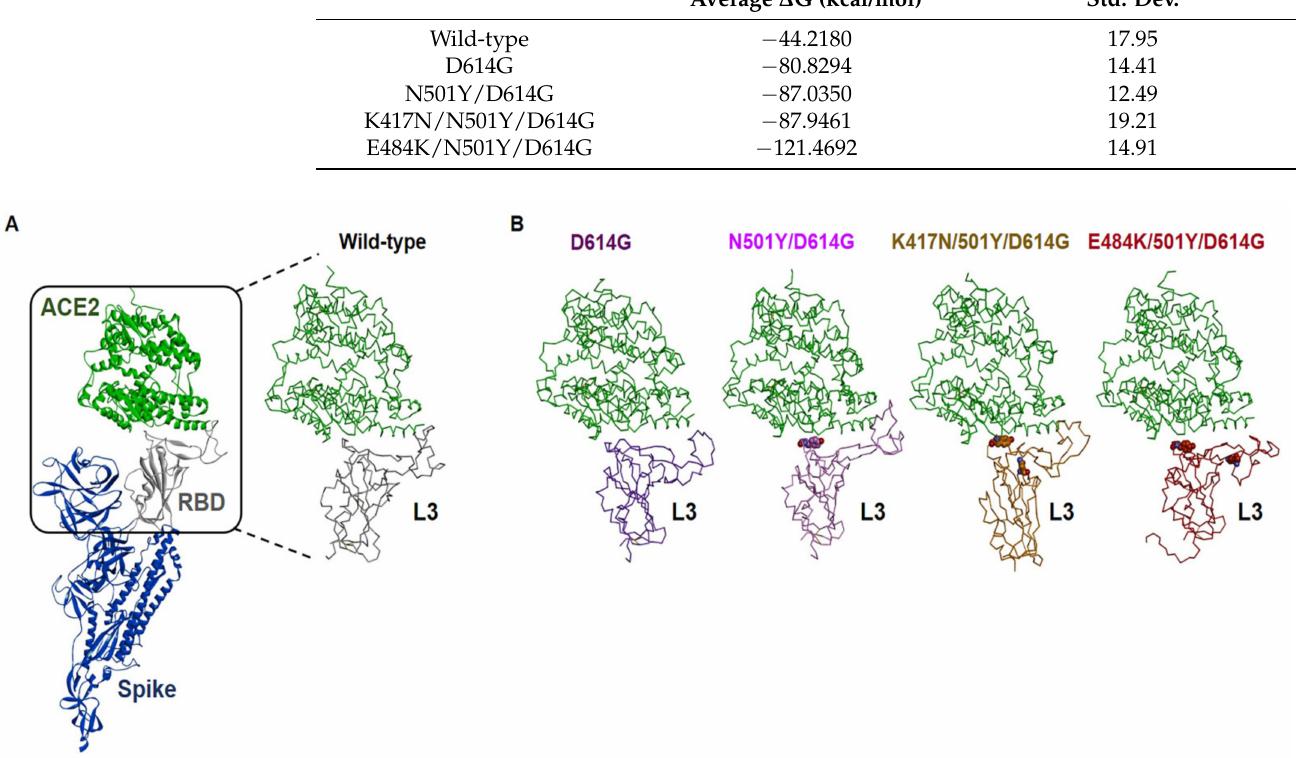
Figure 2. MD simulations of four mutants of the SARS-CoV-2 spike/ACE2 complex structures. ( A ) Homology model of building missing residues in the spike protein, and RBD binding interface of the wild-type spike protein. ( B ) Diverse conformational changes of flexible loop-3 (L3) region in the RBD of SARS-CoV-2 spike by MD